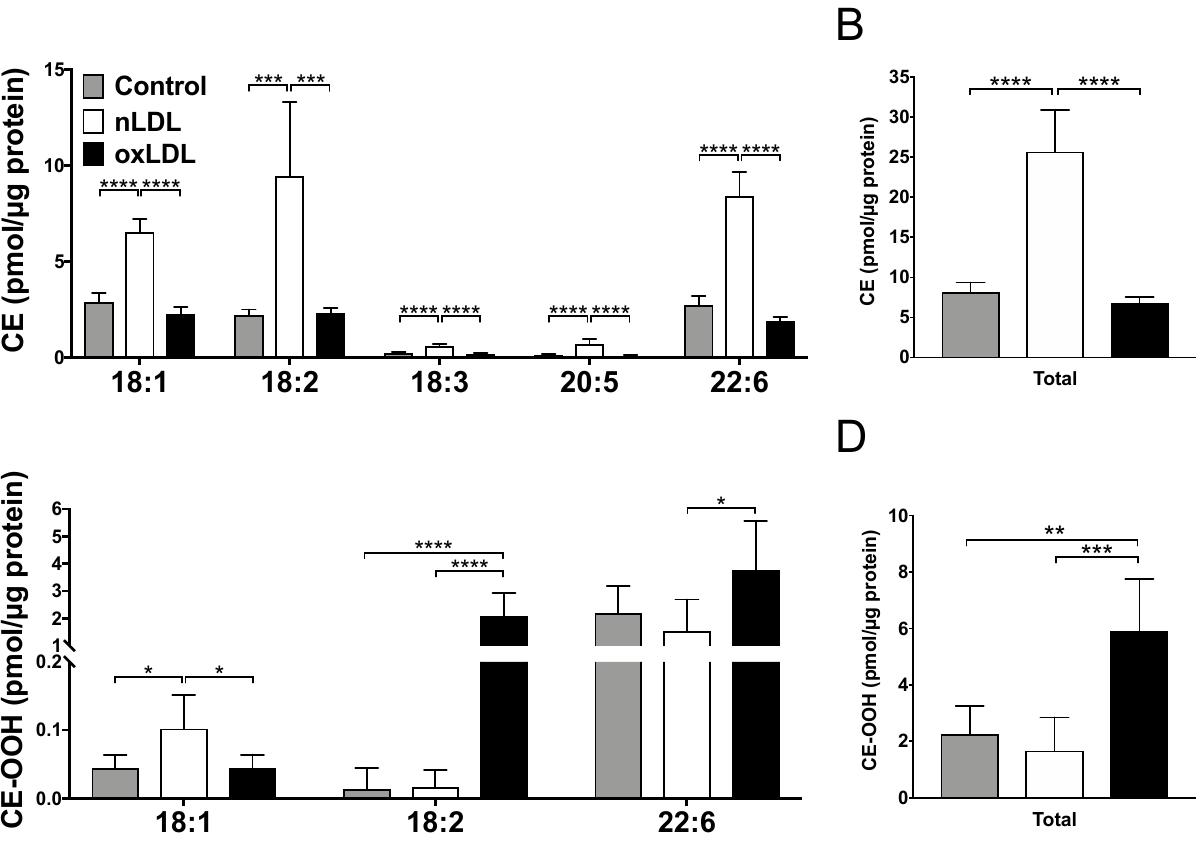
Figure 3. Comparison of CE and CE-OOH species in the LDL-supplemented C3A cells detected using Orbitrap LC-MS/MS. ( A ) CE species. ( B ) The sum of CEs detected in this experiment. ( C ) The CE-OOH species. ( D ) The sum of CE-OOHs detected in this experiment. Results are shown as mean ± standard deviation. n = 6. One-way ANOVA with Tukey’s multiple comparisons test, * p < 0.05, ** p < 0.01, *** p < 0.001, **** p < 0.0001. Three types of CE-OOH molecules (CE-OOH 18:1, CE-OOH 18:2, and CE-OOH